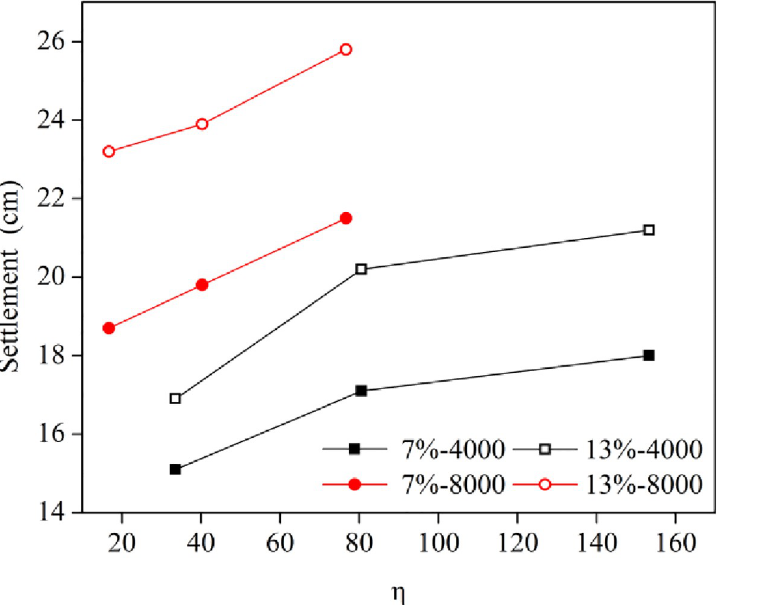
Fig 10. Curves of the final settlement verses the η